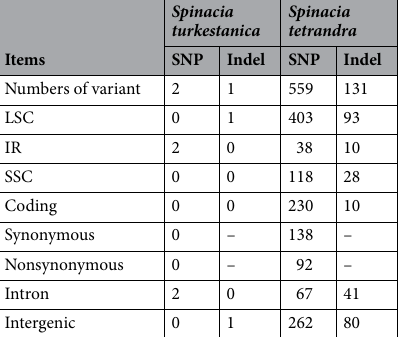
Table 2. Summary of the variation between S. oleracea and the two wild progenitors.